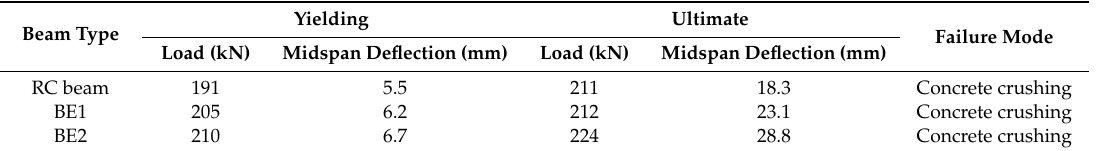
Table 2. Yield and ultimate load, and related midspan deflection of test beams.